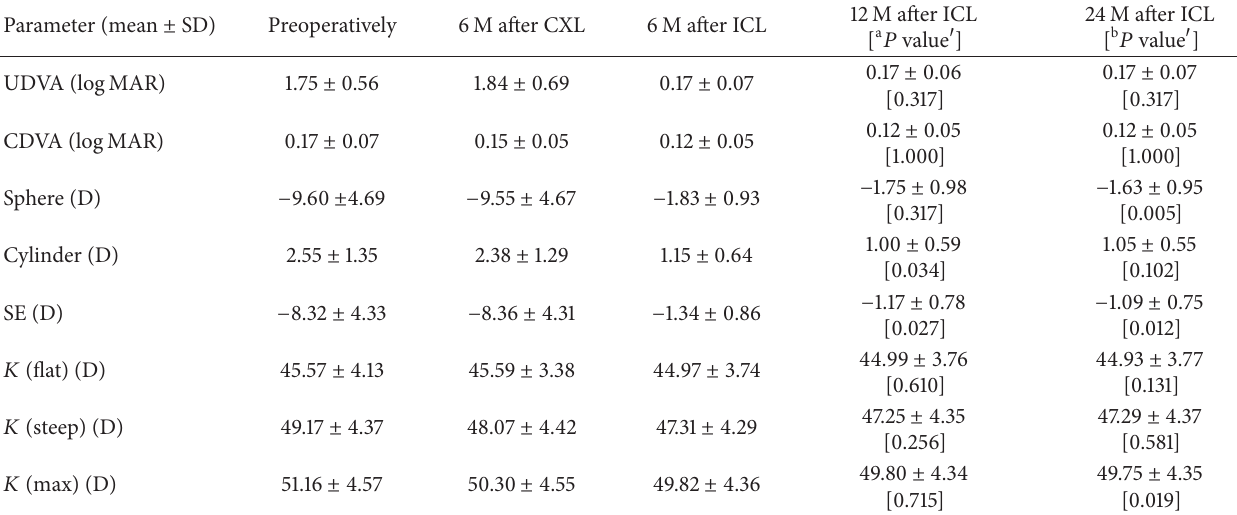
Table 2: Complete case analysis of 10 eyes with 24 months of follow-up ( 𝑁 = 10